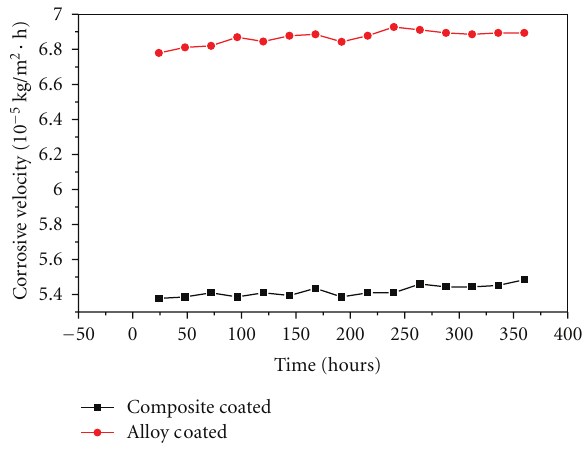
Figure 2: Corrosion rate with immersion time for Zn-Ni coating and composite coating samples in 3.5% NaCl solution.